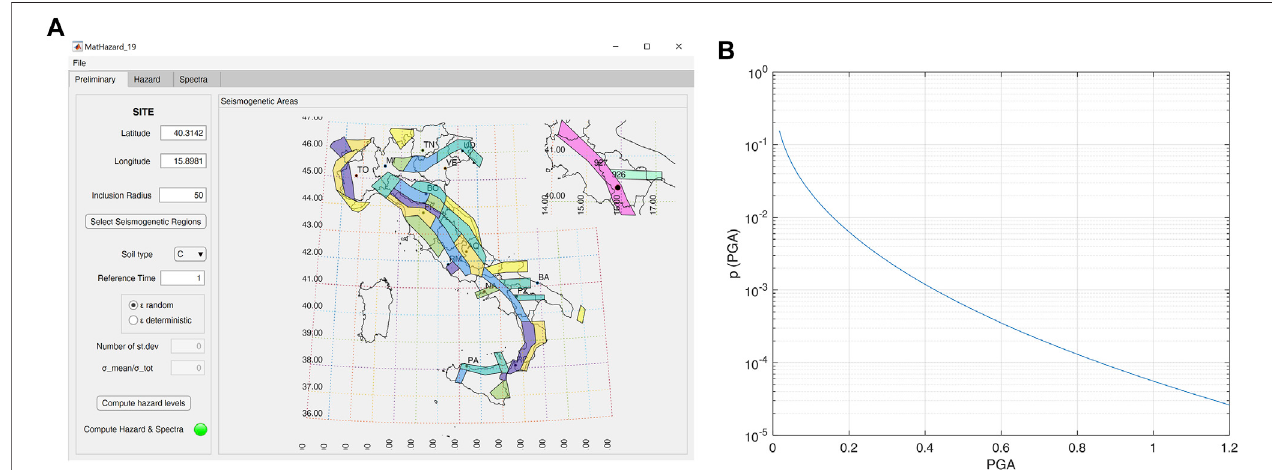
FIGURE 4 | (A) MatHazard software interface for PSHA; (B) seismic hazard curve of Viggiano city (Italy).